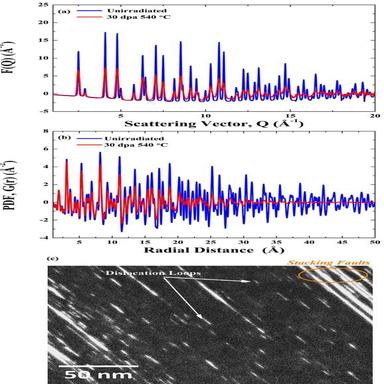
(a) Representative experimental reduced structure function F(Q) for pristine and neutron irradiated 3C-SiC; (b) the corresponding Pair Distribution Functions G(r), (c) a dark-field TEM image for a SiC specimen irradiated to a dose of 30 dpa at 540°C is included for reference (adapted from \).